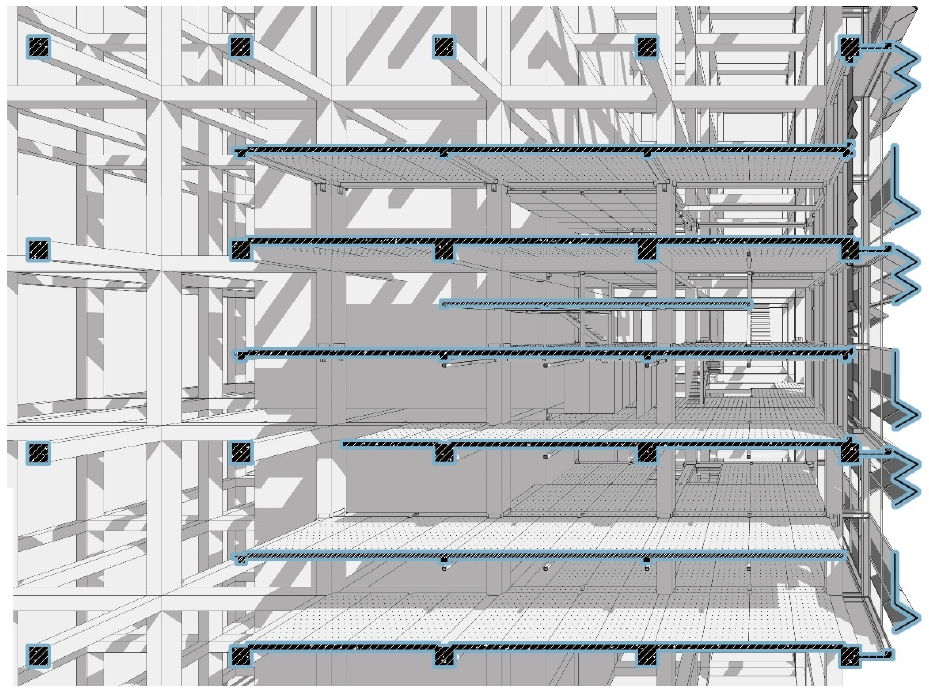
Figure 17. Schematic diagram for the installation of standardized architectural components (Source: author).